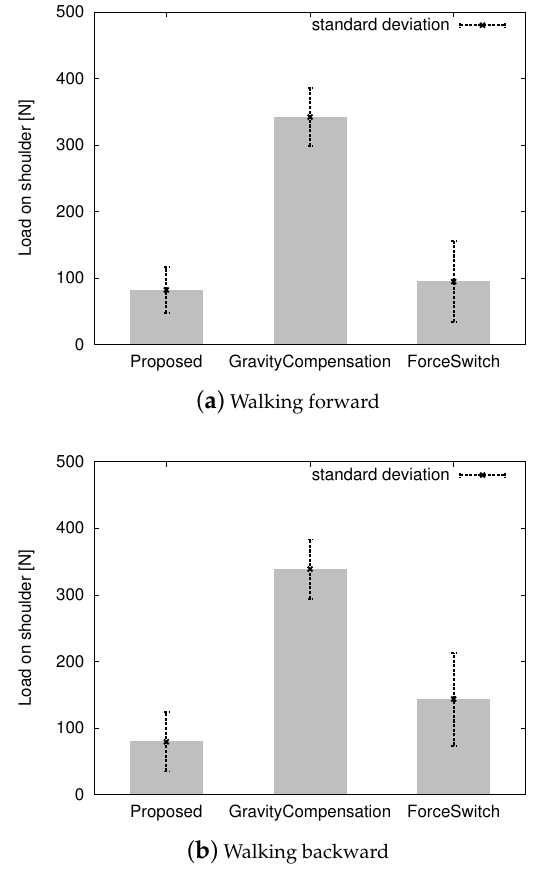
Figure 10. Average load on the shoulders while